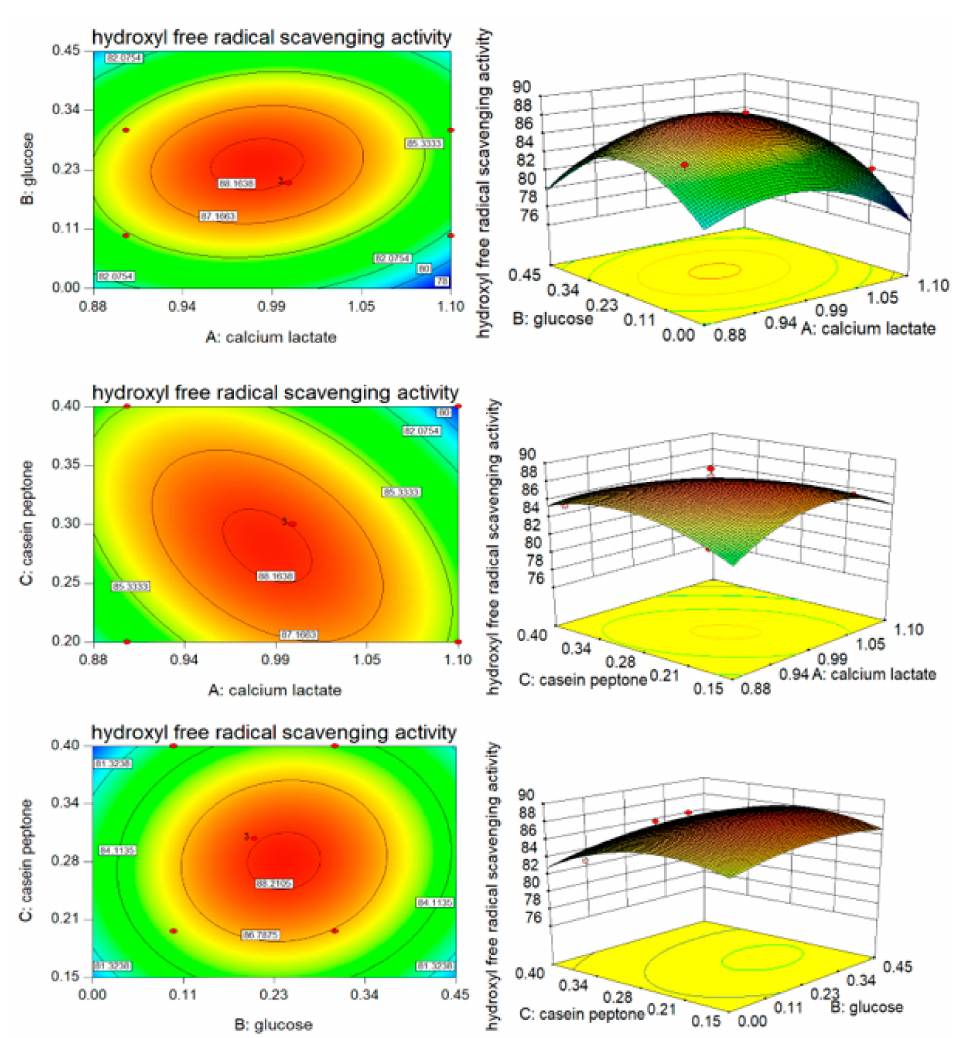
Figure 3. Contour plots and response surface plots of calcium lactate (A), glucose (B), and casein peptone (C) for the hydroxyl free radical scavenging rate (Y 1